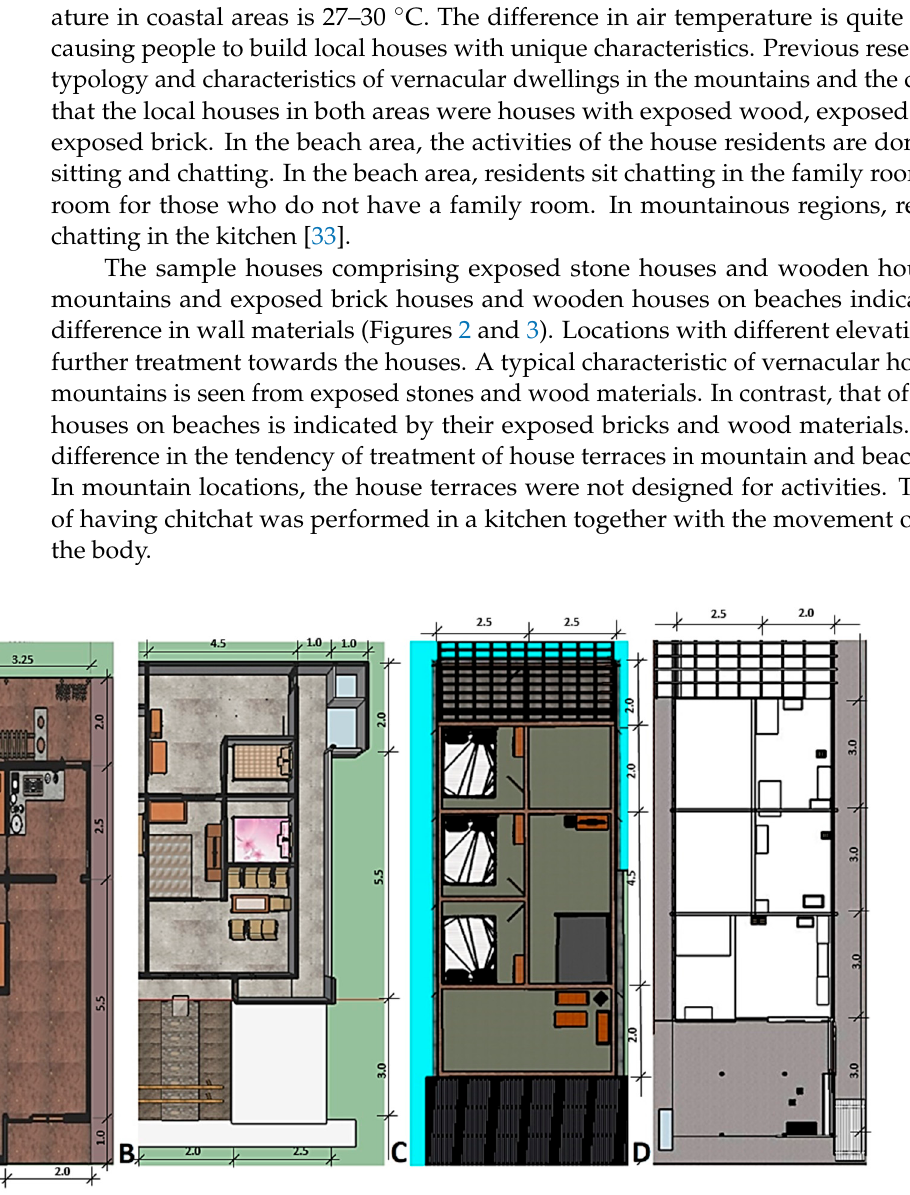
Figure 2. The floor plan of the sample houses: ( A ) exposed stone houses in the mountains, ( B ) wooden houses in the mountains, ( C ) exposed brick houses on beaches, and ( D ) wooden houses on beaches.